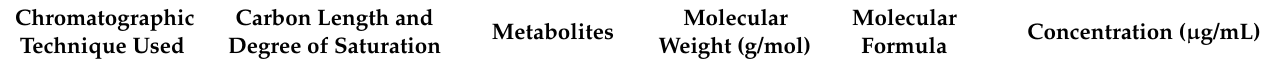
Table 5. Results of chromatographic analysis of AGSUN 5102 CLP and AGSUN 5106 CLP